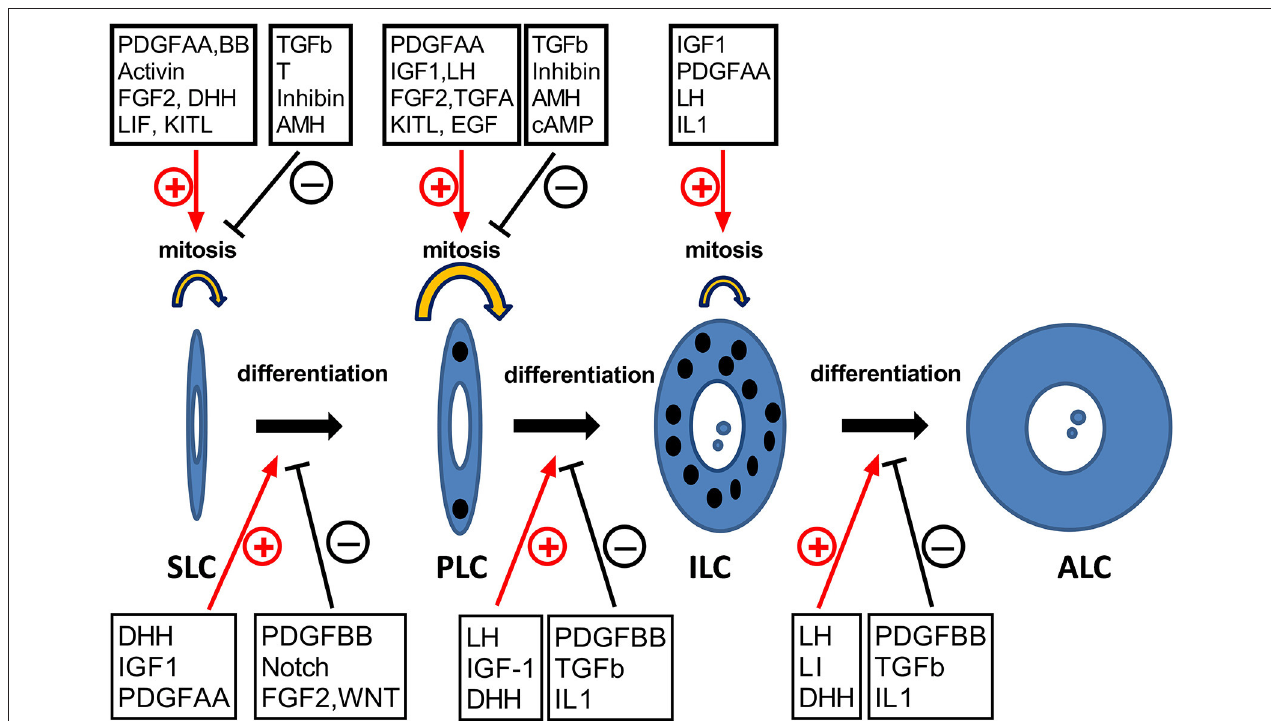
FIGURE 3 | The hormones and growth factors that may potentially regulate the development of Leydig cells. SLC, PLC, ILC, and ALC represent stem, progenitor, immature, and adult Leydig cells, respectively. L , stimulation; θ , inhibition.